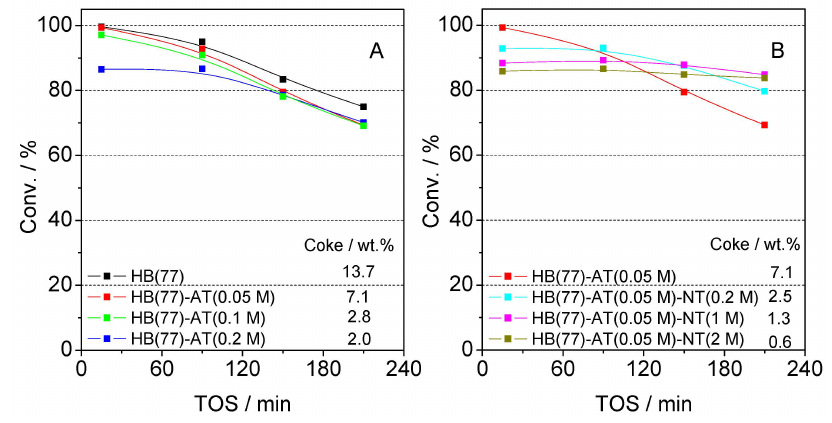
Figure 15. Change in n -hexane conversion with time on stream (TOS) for HB(77), alkali-treated HB ( A ) and alkali-acid-treated HB ( B ) catalysts. Reaction conditions: see Figure